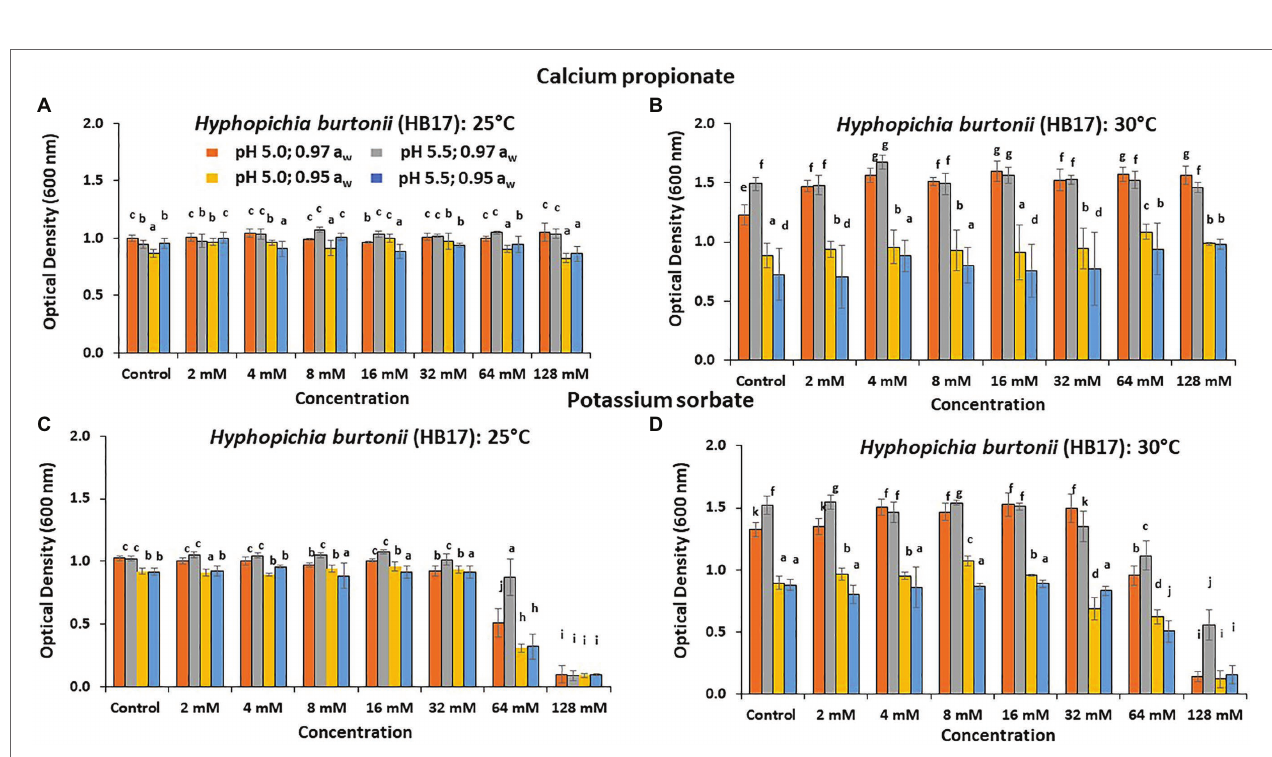
FIGURE 2 | Effect of CP on growth (8,640 min, 6 days) of Hyphopichia burtonii (HB17) at (A) 25 ° C and (B) 30 ° C. The effect of PS on growth is shown in (C) 25 ° C and (D) 30 ° C, respectively. Bars represent the SEM. Treatments with different letters are significant ( p =